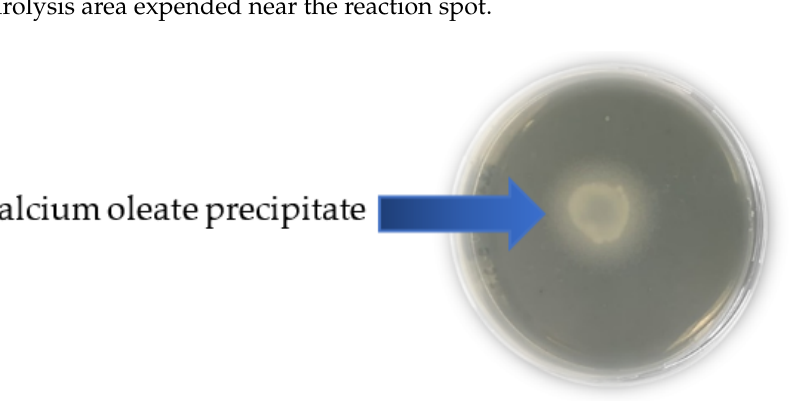
ysate of oil substrate reacted with 0.001% Rhodamine B to create a red-orange, fluorescent halo under 350 nm UV light (Figure 2). However, the highest lipase activity for Psychro- bacter SC65A.3 was observed to be a concentration of 1% sunflower and 1% olive oil.